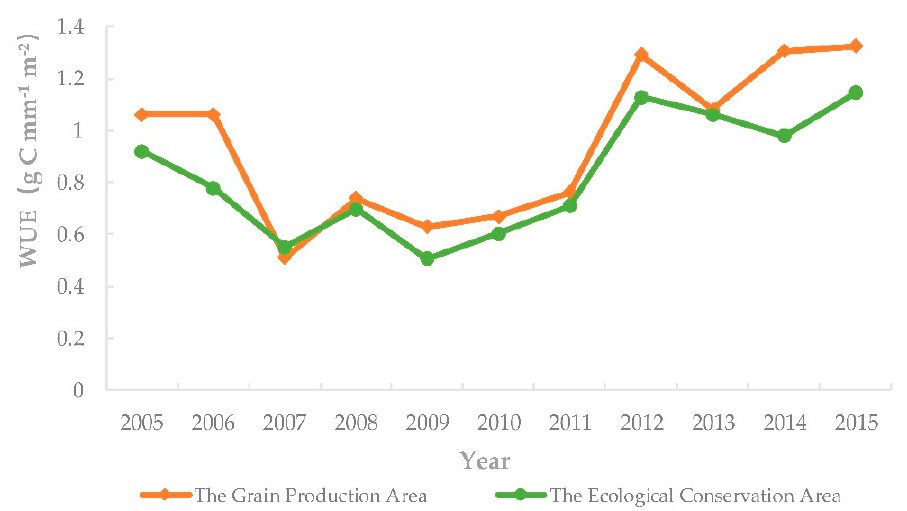
Figure 7. Temporal changes in the green space WUE in the grain production area and the ecological conservation area.